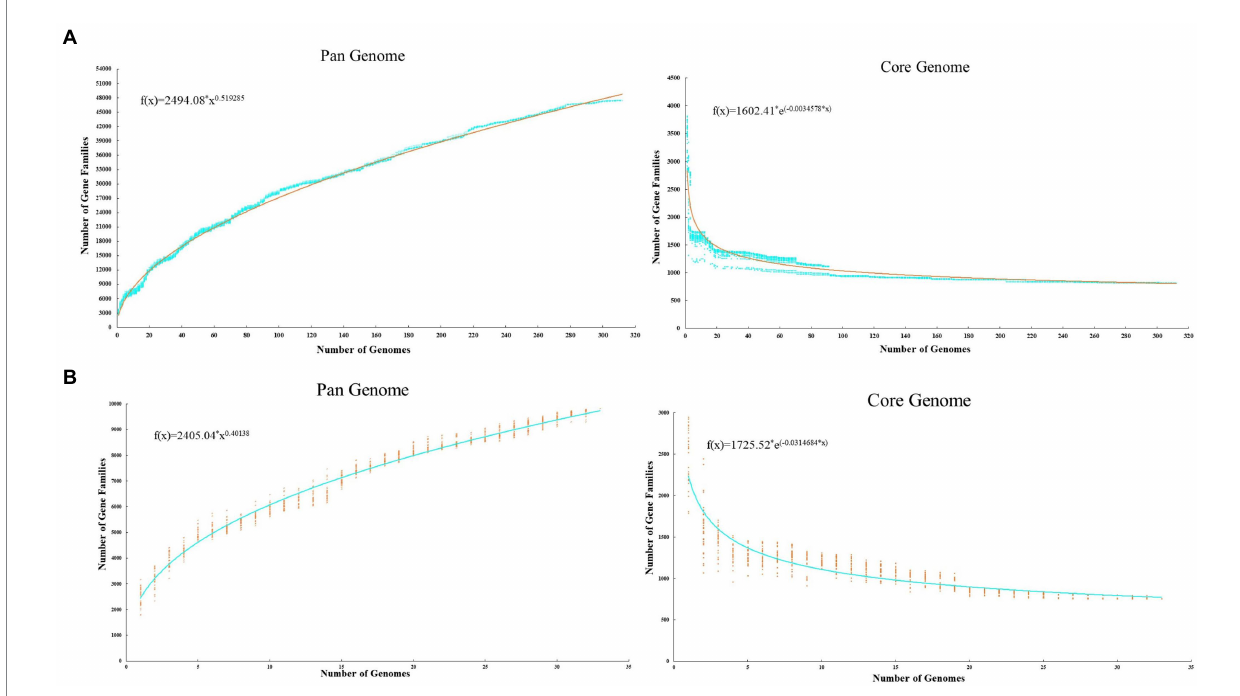
FIGURE 2 Pan and core genome plot of 312 Acinetobacter strains (A) and 33 typic Acinetobacter strains (B) . The plot shows how the number of gene families increase and decline in the pan and core genome with each consecutive addition of the Acinetobacter